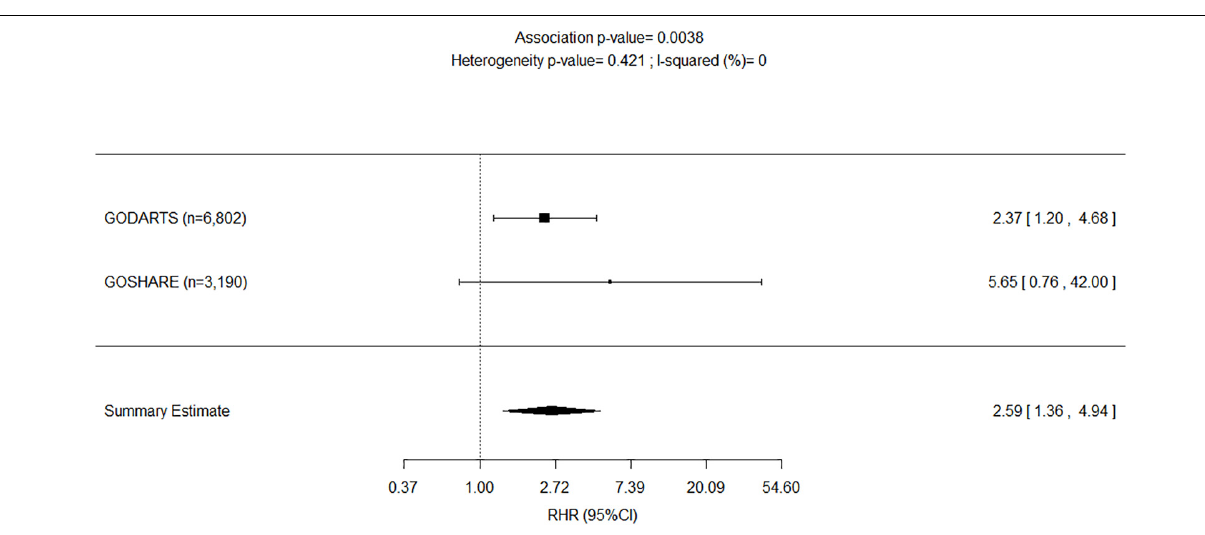
and genotype was included in the model as mentioned